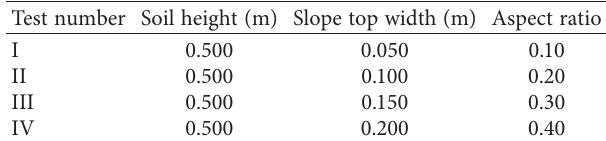
Table 2: List of